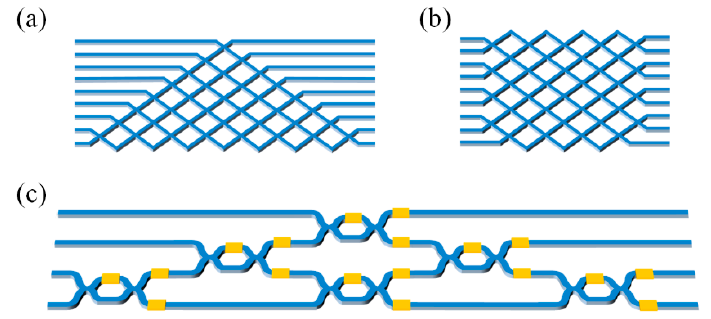
Figure 9. Two decomposition schemes of the MZI matrix core. ( a ) Triangular [47] and ( b ) rectangular decomposition schemes [51]. ( c ) A typical MZI matrix core based on triangular decomposition.